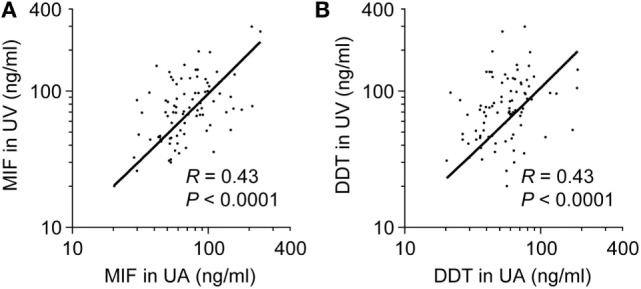
Comparison of umbilical artery (UA) to umbilical vein (UV) macrophage migration inhibitory factor (MIF) and d-dopachrome tautomerase (DDT) plasma concentrations. Scatterplot comparing MIF (A) and DDT (B) plasma concentrations in UA and UV in 86 (A) and 88 (B) paired measurements from preterm and term newborns. The regression lines are shown.